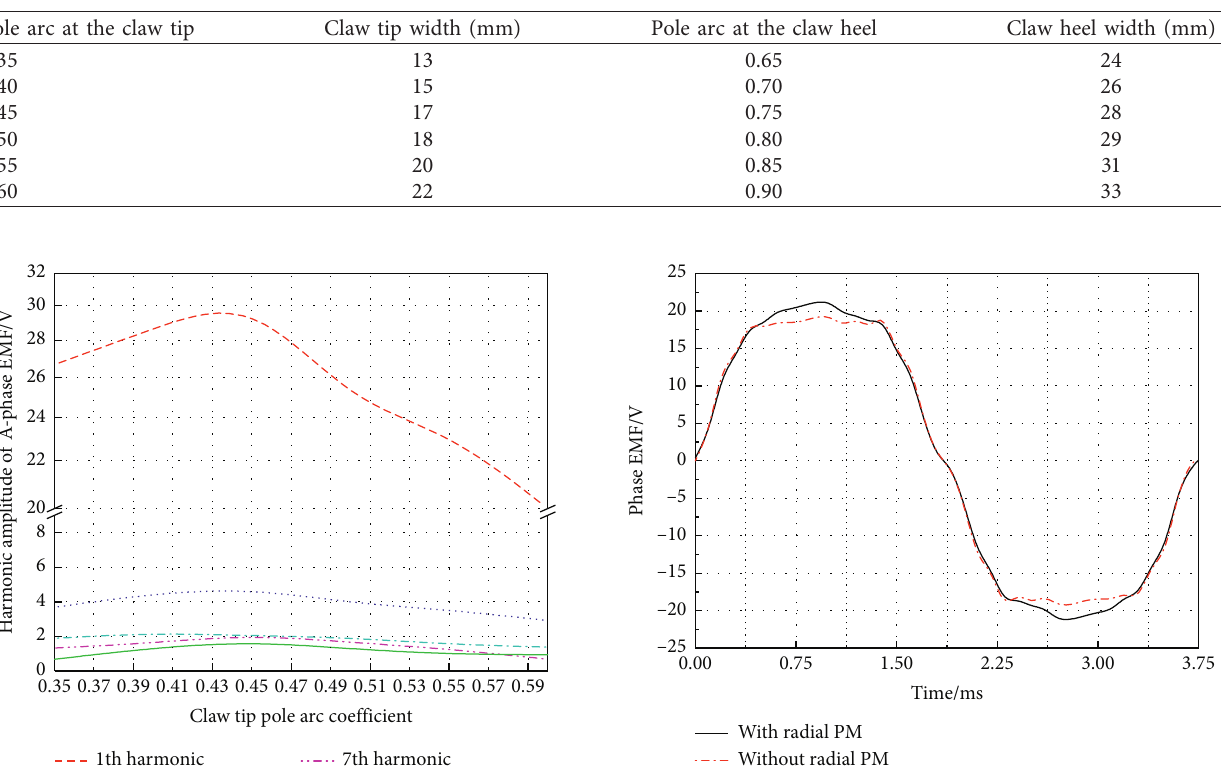
Table 4: Parameters of the claw pole with different claw tip pole arcs.